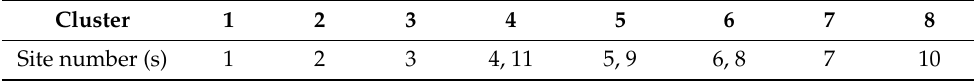
Table 5. Clusters with different